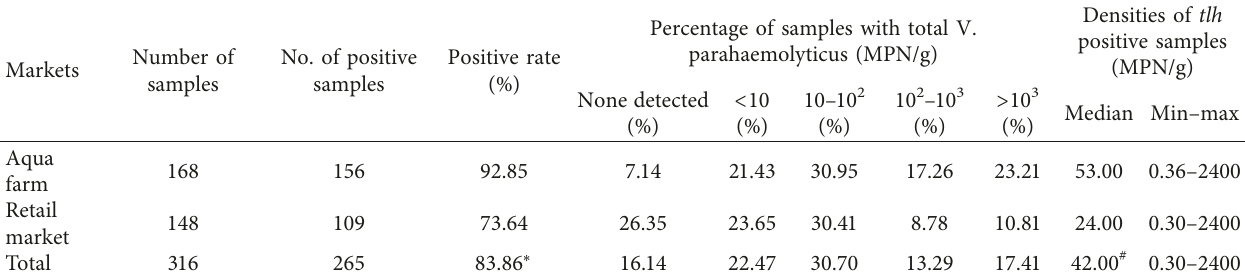
Table 4: Prevalence of contamination of total Vibrio parahaemolyticus in Anadara subcrenata in different markets.